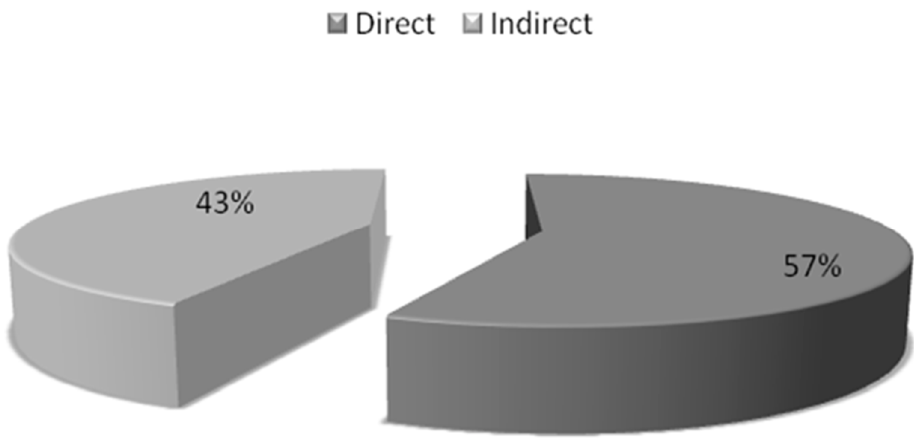
Figure 4. Percentages of direct and indirect costs.